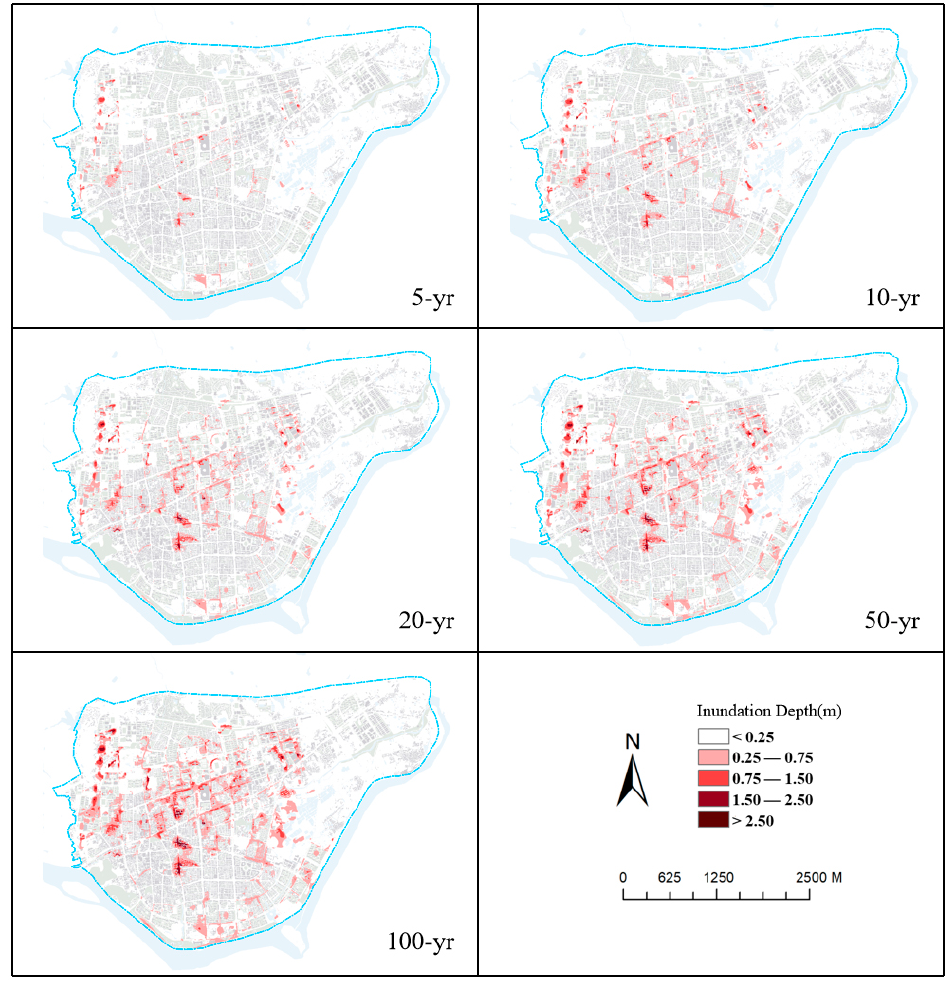
Figure 7. Flooding simulation results under different rainfall return periods (5, 10, 20, 50, and 100 yr).